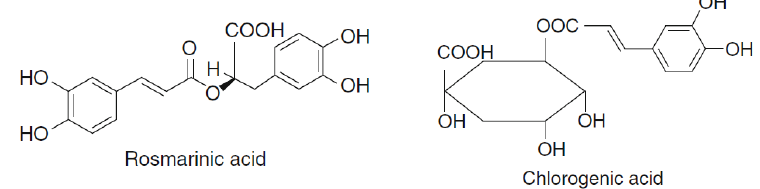
Figure 2. Chemical structures of rosmarinic acid and chlorogenic acid.